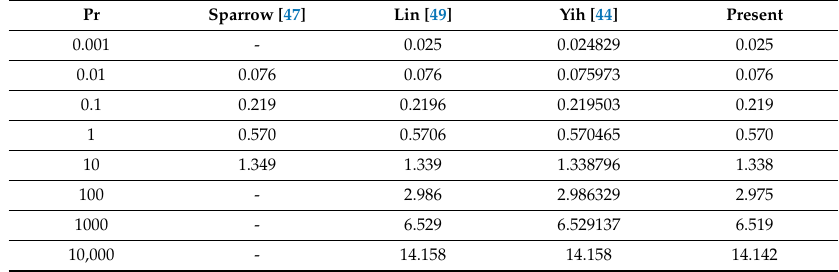
Table 2. Comparison of results of dimensionless heat transfer when Nb = Nt = 0, δ v = δ T = 0, Da → ∞ , R → ∞ , λ = Ω = M = 0, K =